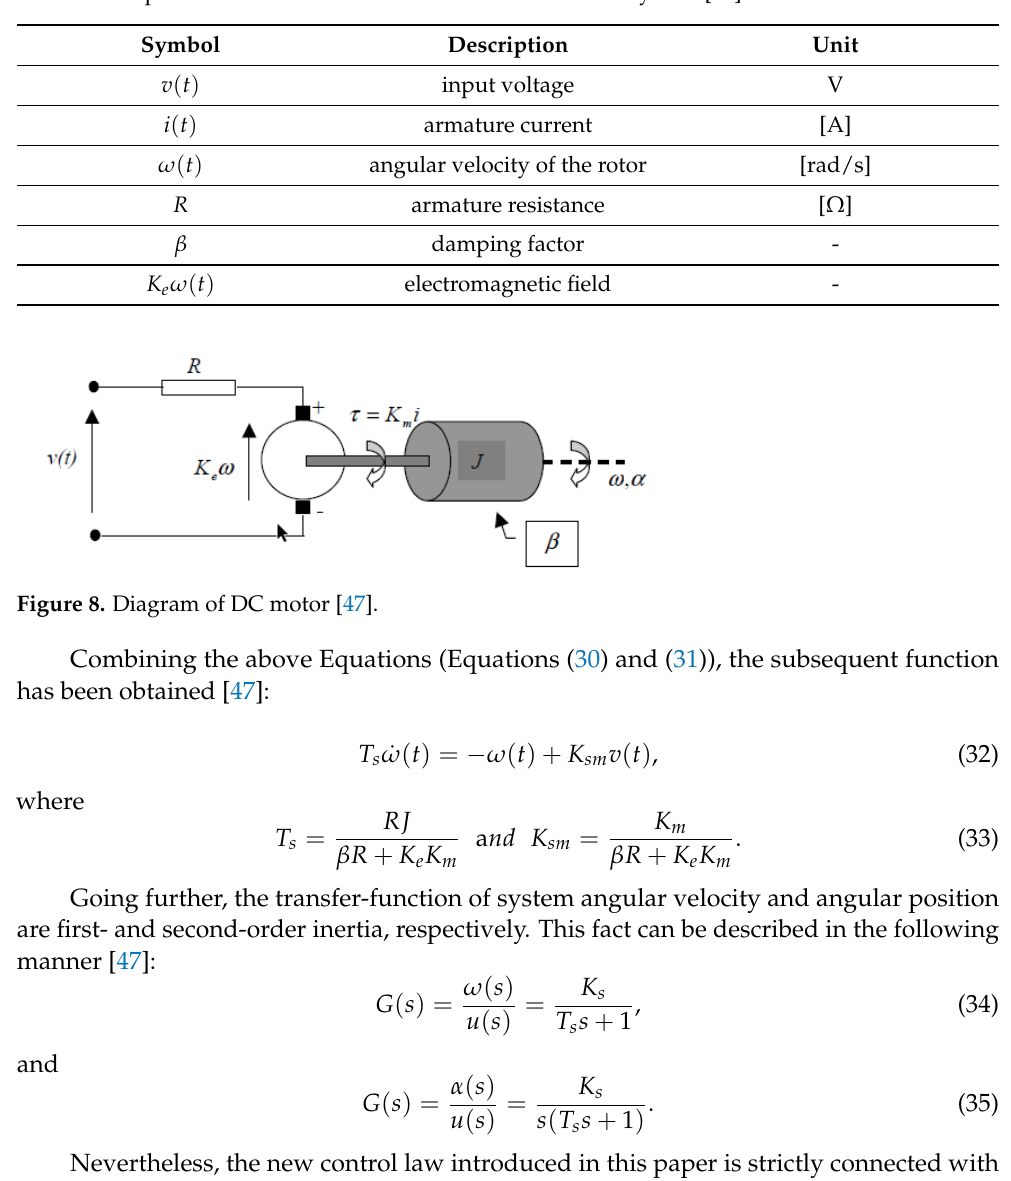
Table 3. The parameters of the sensor-aided servomechanism system [47].